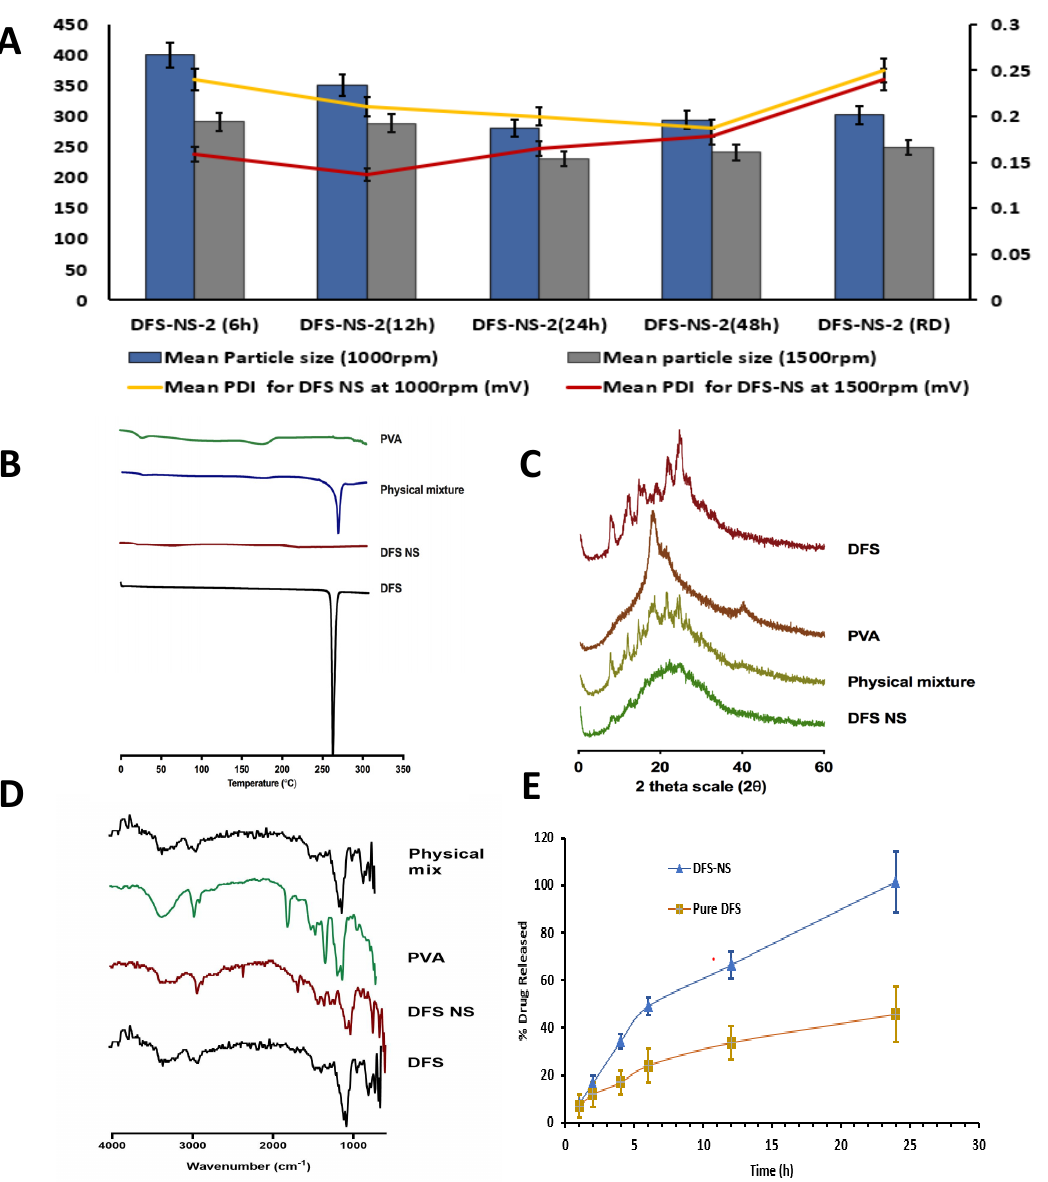
Figure 3. Particle size and PDI at 6, 12, 24, 48 h of milling and RD after freeze-drying at ( A ) 1000 rpm and 1500 rpm milling speed expressed as means + SDs, n = 3. ( B ) Differential scanning calorimetry thermogram of PVA, physical mixture of DFS and PVA, DFS-NS and DFS, ( C ) Powder X-ray diffraction of plain DFS, PVA, physical mixture of DFS and PVA and DF-NS, ( D ) Fourier transform infrared analysis of DFS, PVA, and DFS-NS. ( E ) In vitro release profile of DFS-NS and pure DFS by employing dialysis membrane and PBS as release media, expressed as the means ± SDs, n =